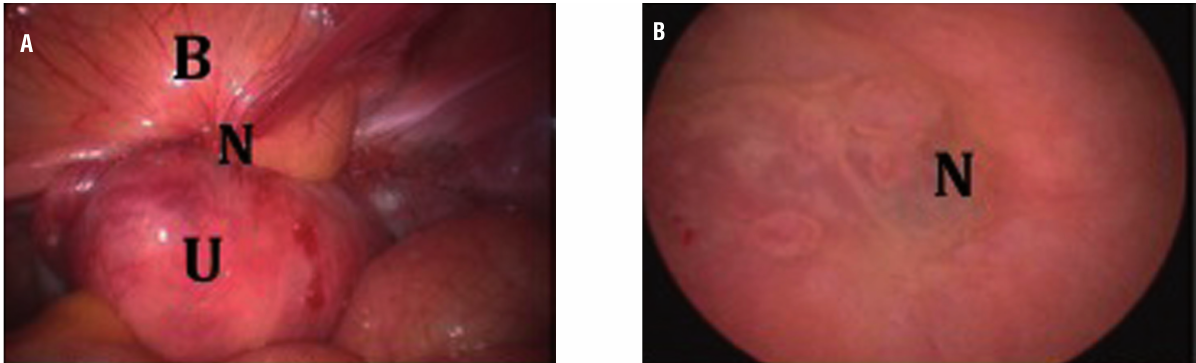
Figure 1D - A - Endometriosis in laparoscopic view, B - Endometriosis in cistoscopic view.